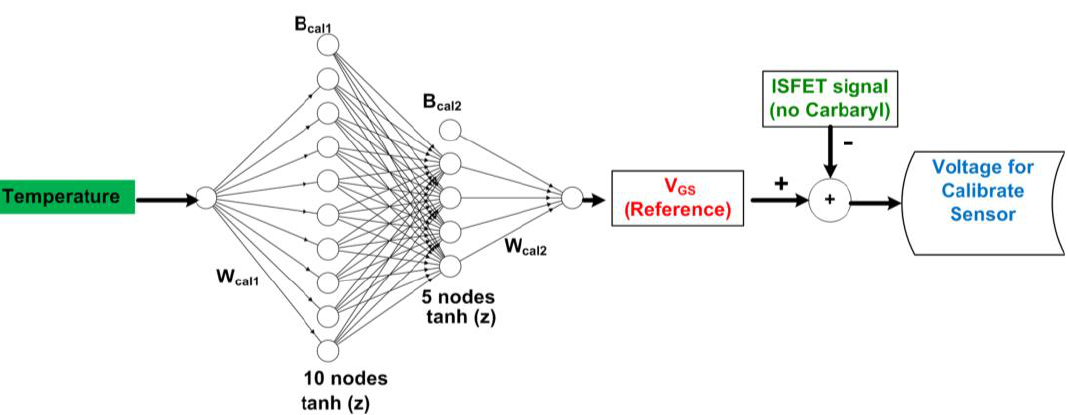
Figure 3. The single-input deep learning regression-based model calculates the voltage for calibrating the sensor.